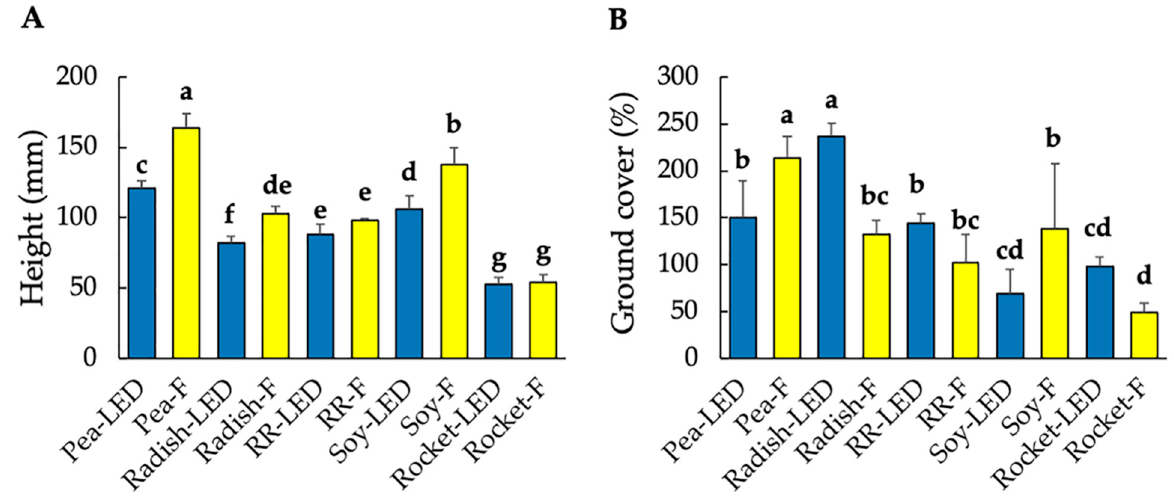
Figure 1. Plant height ( A ) and ground cover ( B ) of green pea, radish, Red Rambo (RR), soybean (soy), and rocket microgreens, cultivated under LED and fluorescent (F) lighting. The different lowercase letters (a–g) represent significant differences between the microgreen species under the different lighting for height and ground cover ( p < 0.05), as determined from a one-way ANOVA.